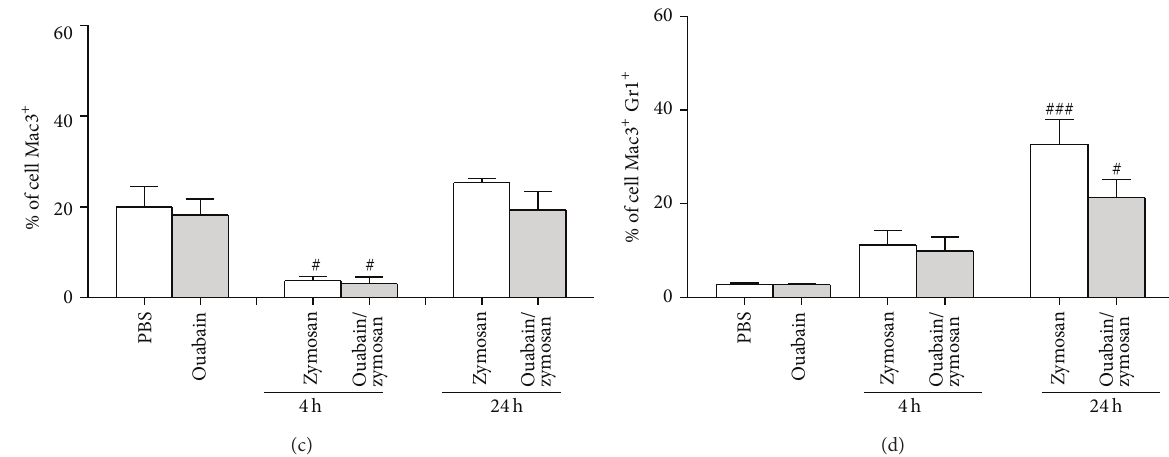
Figure 3: Effect of ouabain on peritoneal cavity leukocyte subsets. Cells were obtained from peritoneal lavage, 4 and 24 h after the injection of the stimuli i.p. Neutrophils, monocytes, and macrophages were distinguished by flow cytometry using anti-Gr-1 and anti-Mac-3 antibodies. (a) Representative experiment showing the patterns of Gr-1 + and Mac-3 expression, as well as the leukocyte populations defined by these molecules. Values of the percentage of neutrophils (Gr-1 + ), macrophages (Mac-3 + ), and monocytes (Gr-1 + and Mac-3 + ) were also added to the dot plots . ((b), (c), and (d)) Data were expressed as mean ± SEM and analyzed by Graphpad Prism using ANOVA with Tukey’s posttest, where all groups were compared. The results were obtained from 6 animals per group. ### 𝑃 < 0.001 and # 𝑃 < 0.05 versus PBS group; ∗∗ 𝑃 < 0.01 versus zymosan